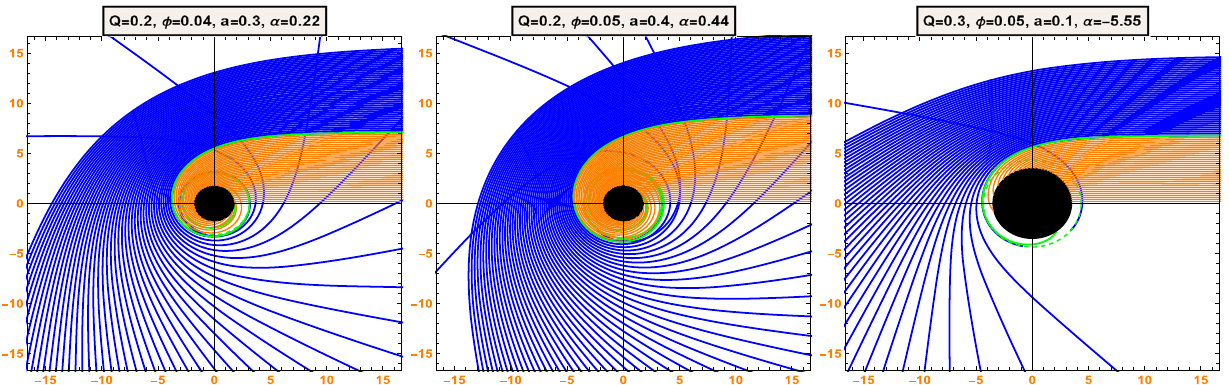
Fig. 3 Thetrajectoriesofphotonringsfordifferentparametersinpolar coordinates ( r ,ϕ) . The considering BH is shown as solid black disks, and the blue, green and orange lines correspond to b > b c , b = b c